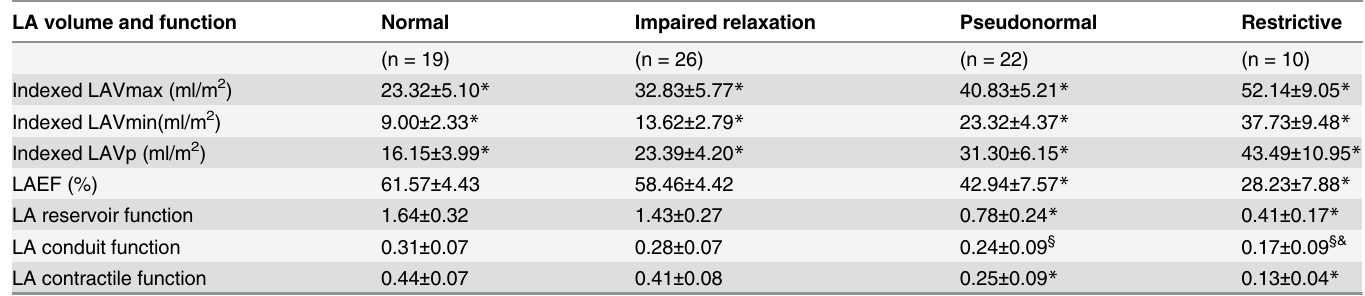
Table 2. Comparison of the LA volume and function among the 4 study groups. LA volume and